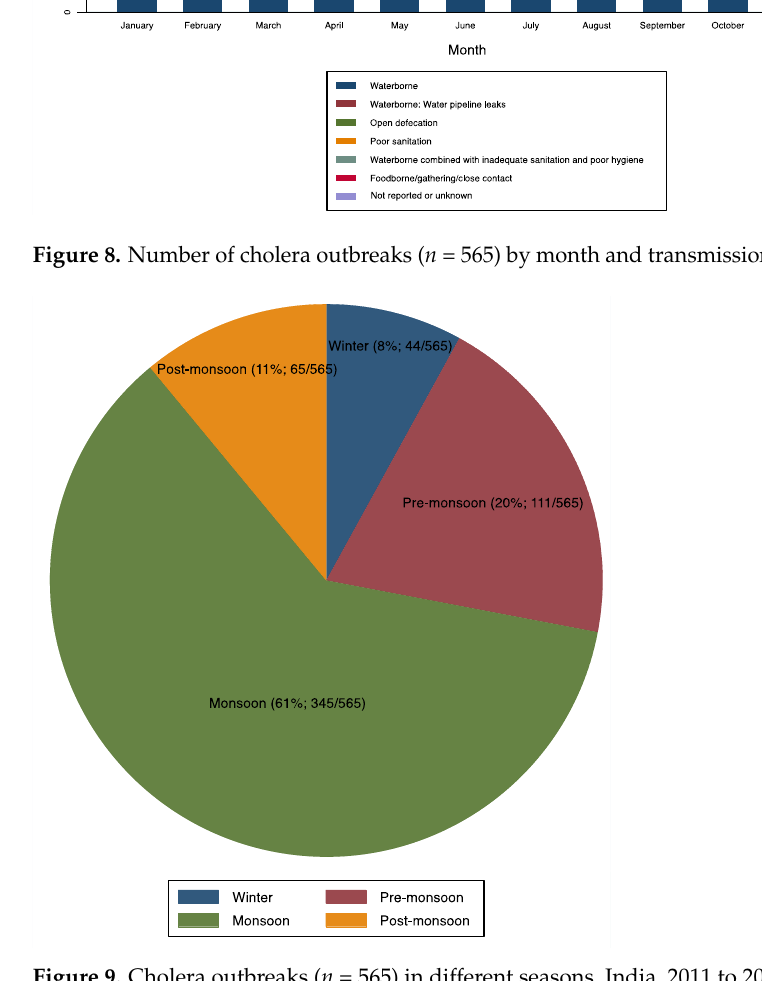
Figure 9. Cholera outbreaks ( n = 565) in different seasons, India, 2011 to 2020. Winter = December to January; Pre-monsoon = March to May; Monsoon = June to September; and Post-monsoon = October to November.